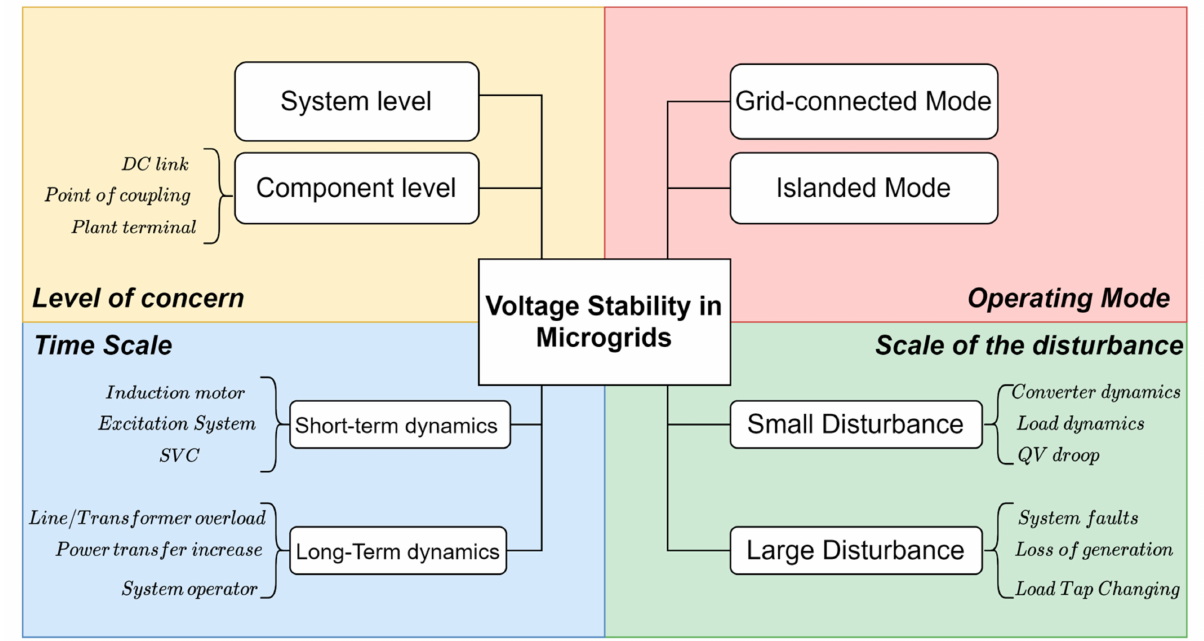
Figure 1. Voltage stability classification in